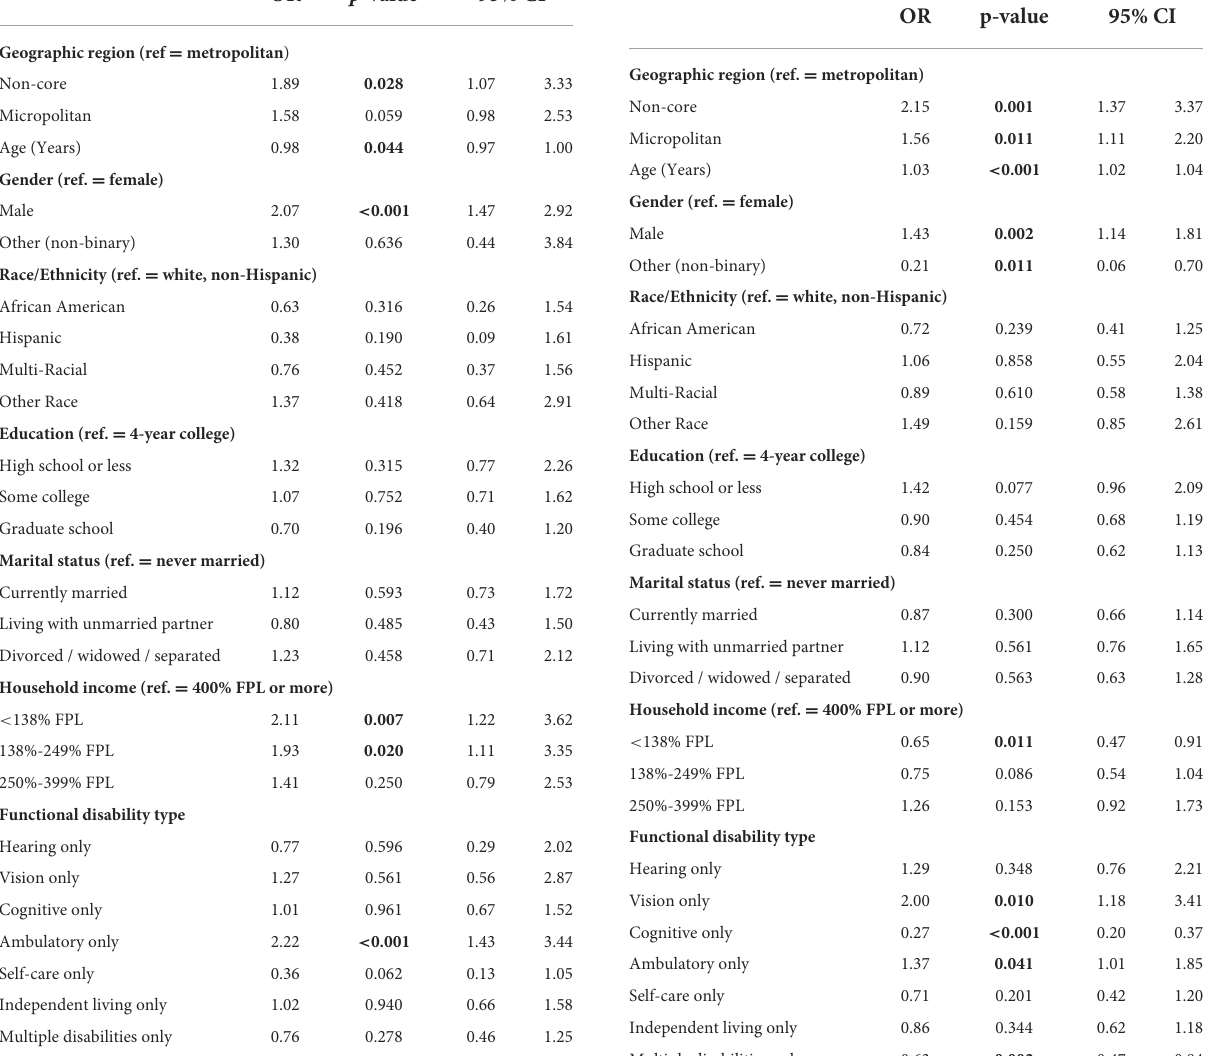
TABLE 3 Multivariate analysis of dental care not needed ( N = 1,705). TABLE 4 Multivariate analysis of mental health care not needed ( N =